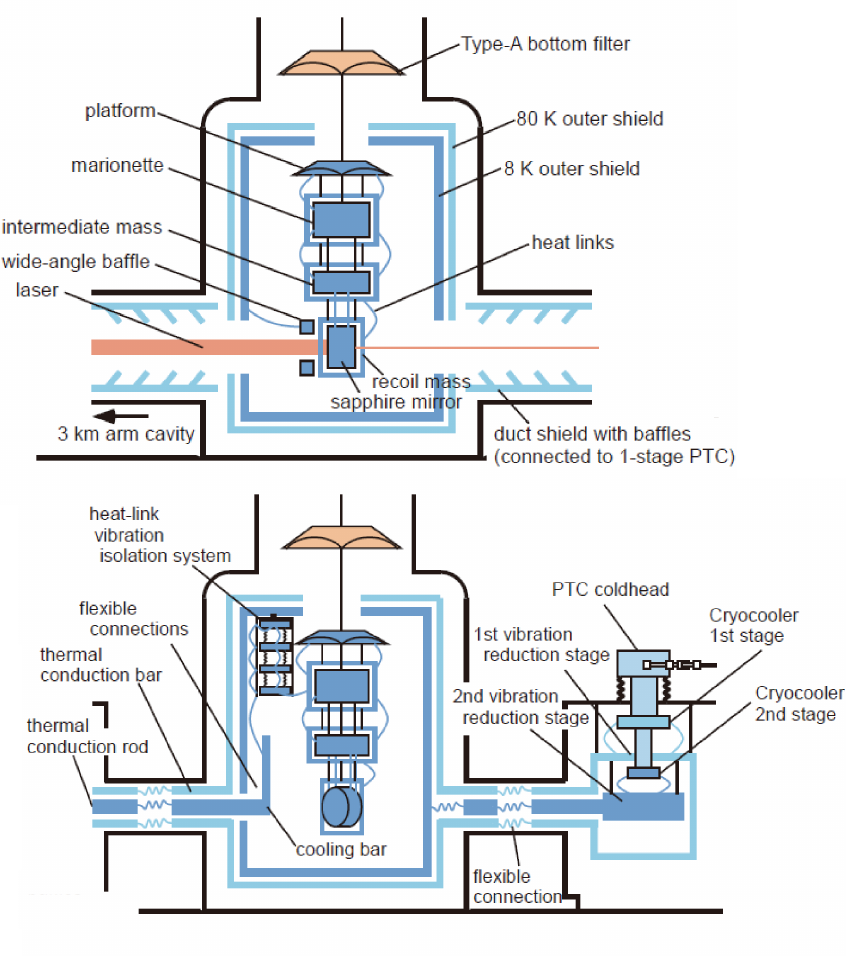
Figure 5. Schematic view of KAGRA’s cryogenic system. A side view of the cryostat from the direction orthogonal to the arm ( top ) and another side view at an angle of 45 ◦ from the direction indicated in the left panel ( bottom ). Adapted with permission from Ref. [8], ©2021 Oxford University